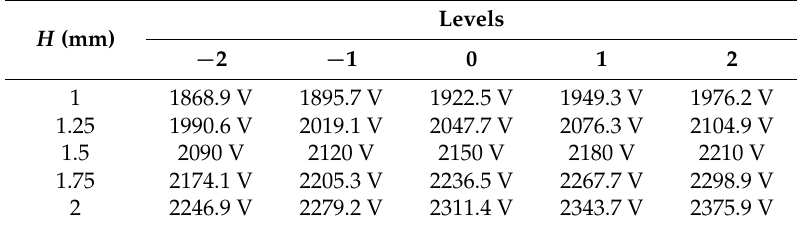
Table 2. The applied voltage values for different nozzle-to-substrate distances and different levels. H (mm)